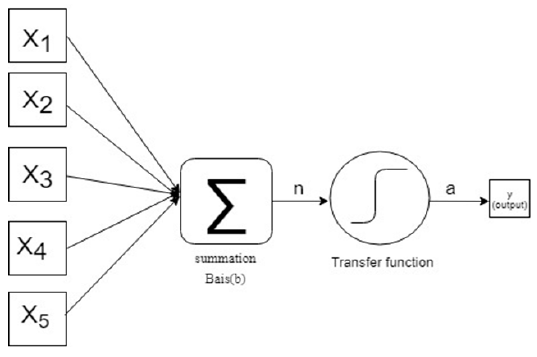
Figure 1. Structural of perceptron network.